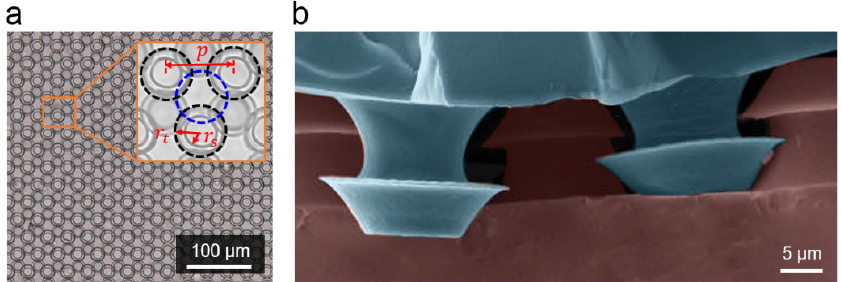
Figure 2. ( a ) Optical microscope images of the interlocked microstructures; ( b ) A cross-sectional scanning electron microscope image of the interlocked microstructures.